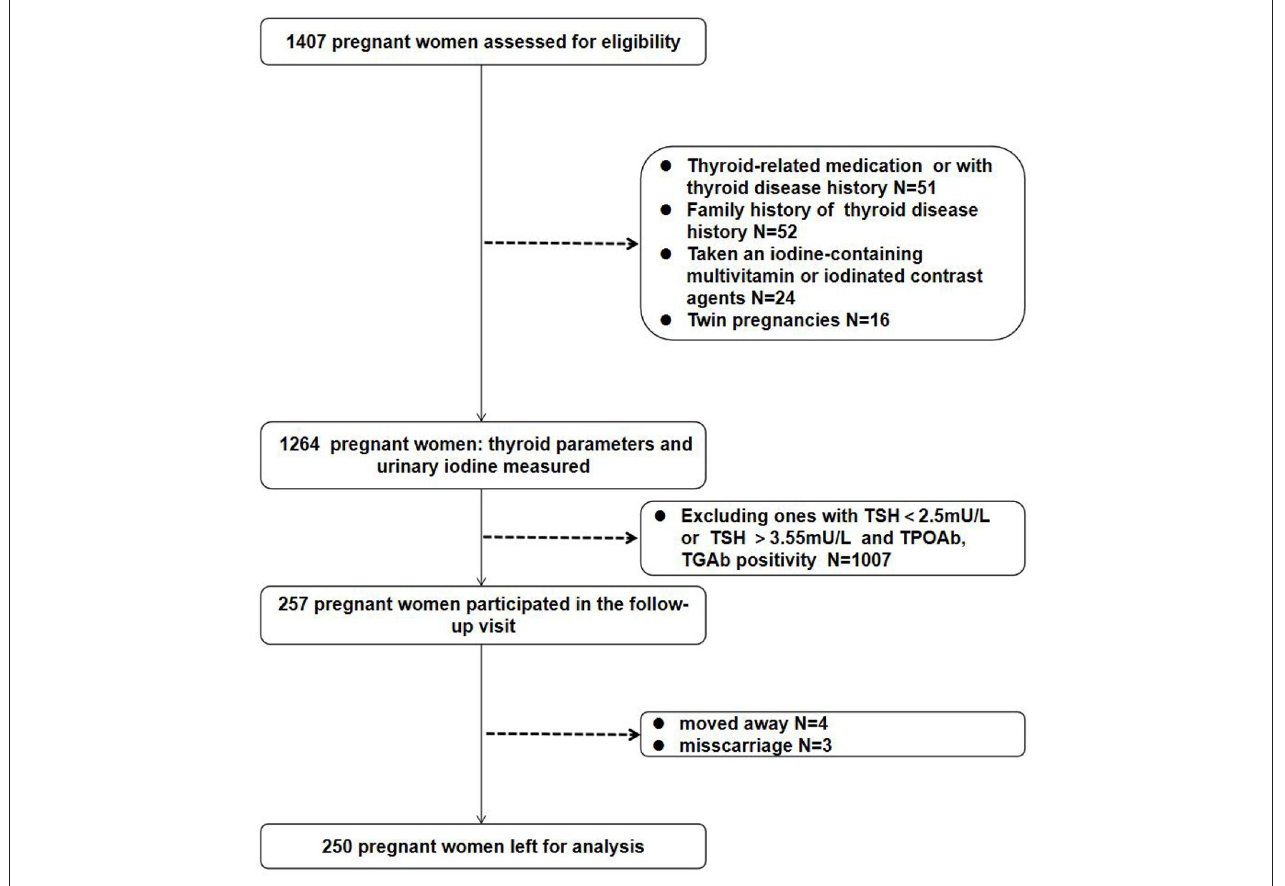
FIGURE 1 | Participant